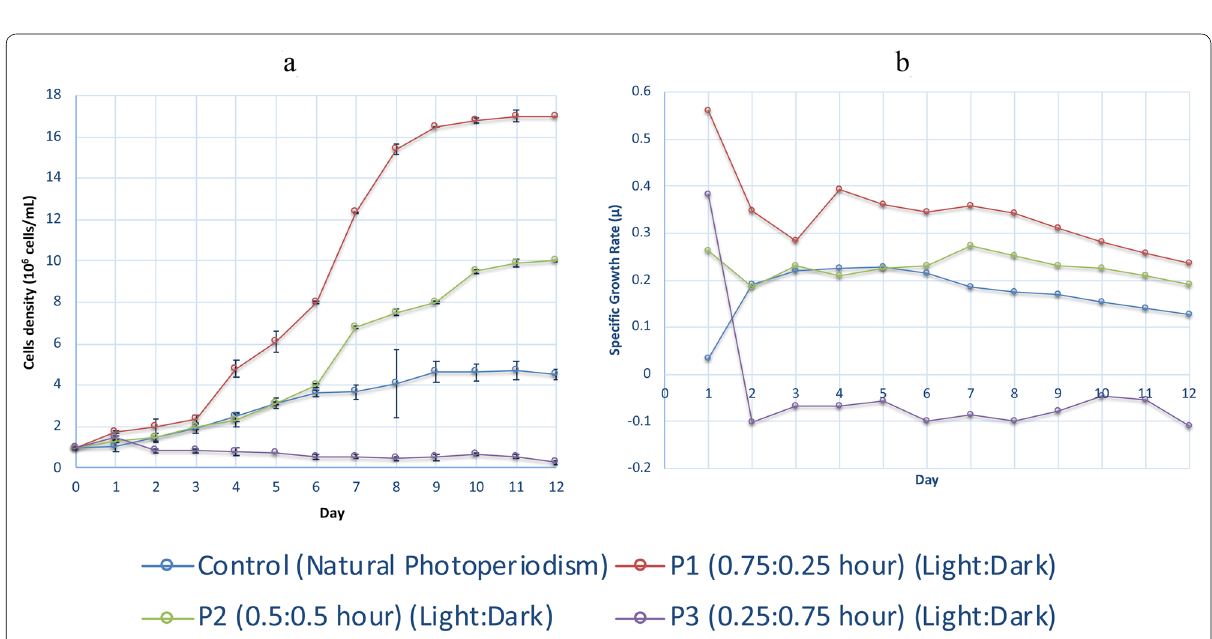
Fig. 5 (a) Growth curve with one sigma standard deviation and (b) specific growth rate for Nannochloropsis sp. on the four low-frequency flashing light